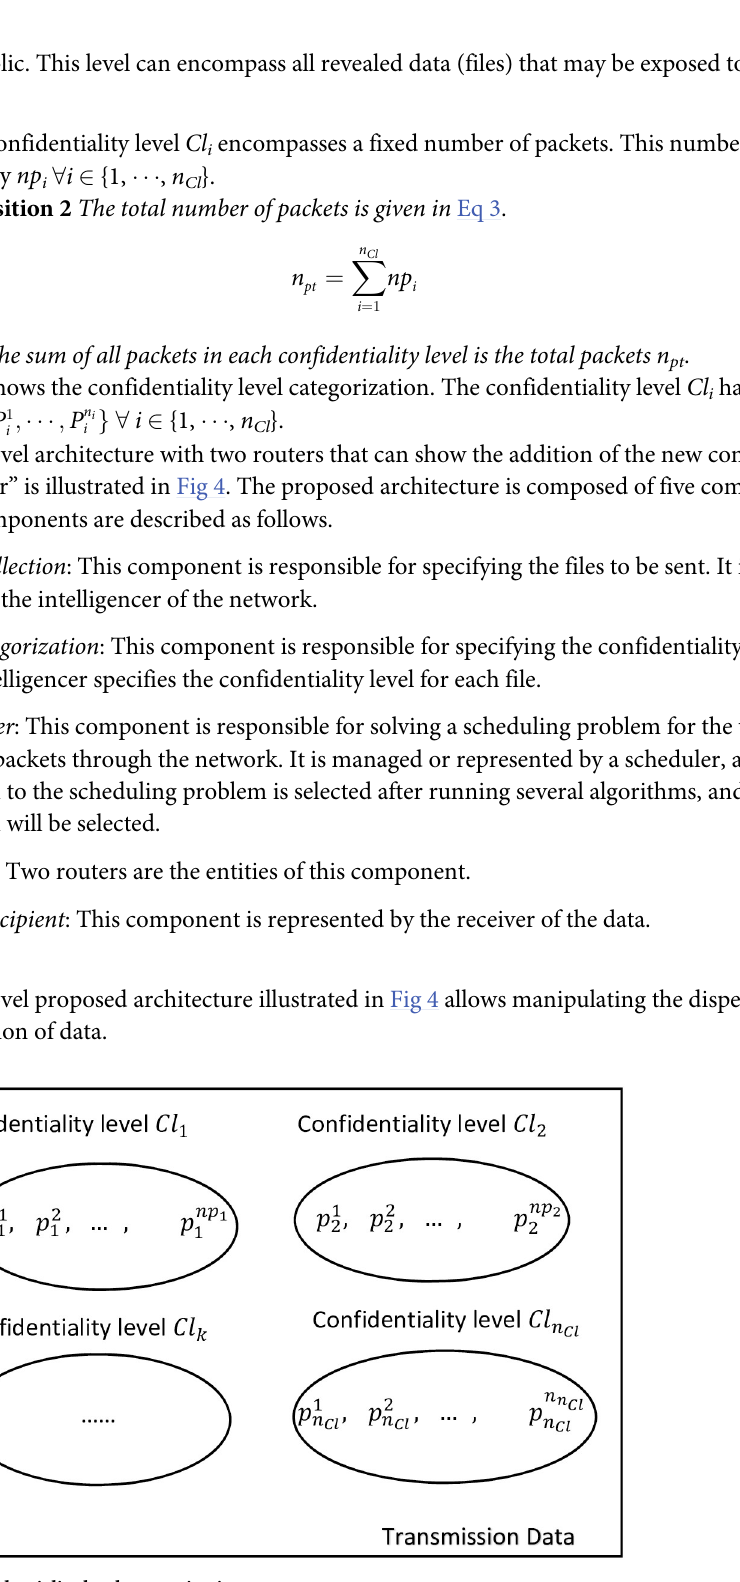
Fig 3. Confidentiality level